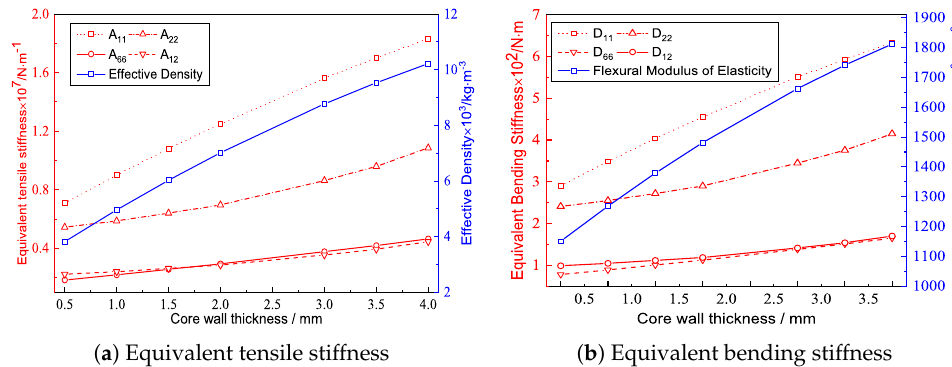
Figure 9. Effects of the core wall thicknessews on the equivalent stiffness of the triangular HSP.